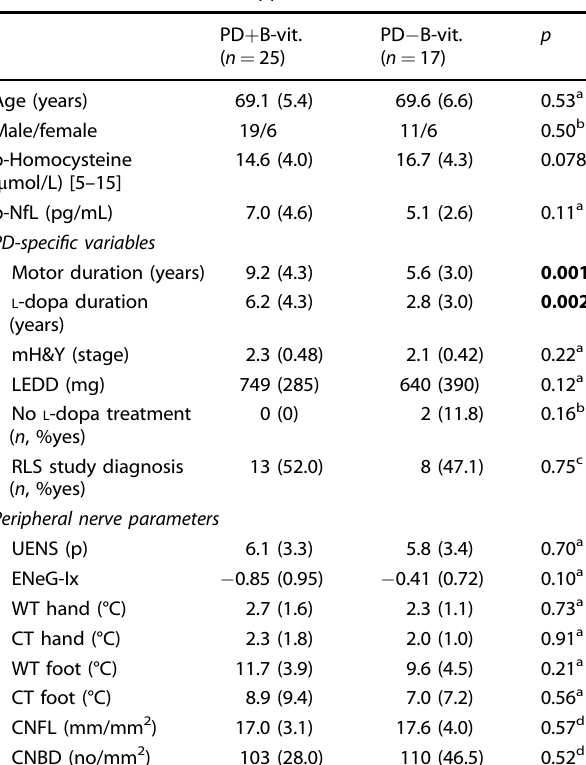
Table 3. Characteristics of subgroup analysis comparing PD patients with and without B-vitamin